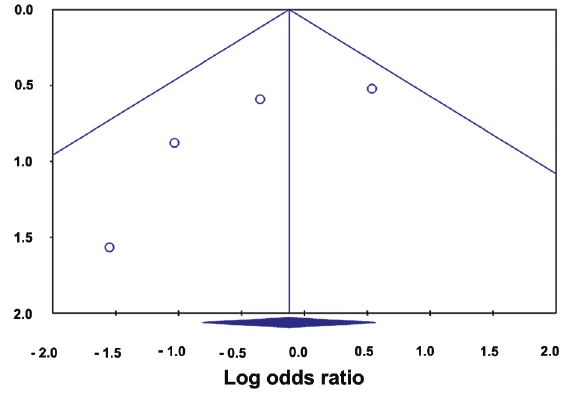
Figure 1 – Funnel plot for randomized studies non-steroidal anti-inflammatory drugs (NSAIDs) vs.